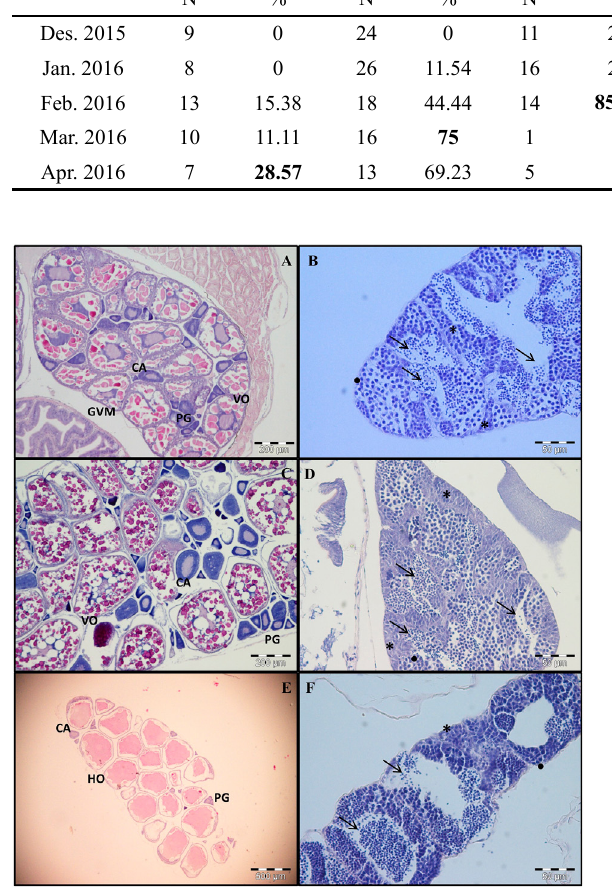
Fig. 5. – Histological sections of spawning capable specimens (stage IV) of Aphia minuta (A, female; B, male), Pseudaphia ferreri (C, female; D, male) and Crystallogobius linearis (E, female; F, male). Spawning capable females of A. minuta and P. ferreri (A, C): secondary growth oocytes at the cortical alveolus stage (CA), vitellogenic oocytes (VO) and germinal vesicle migration (GVM) are observed together with primary growth oocytes (PG); in C. linearis (E), gonads are fully filled with hydrated oocytes (HO), and few primary growth oocytes are observed. Spawning capable males (B, D, F): tubules and vas deferens are full of spermatozoa ( ↘ ); in addition, spermatocytes (*) and spermatids (•) can be observed.